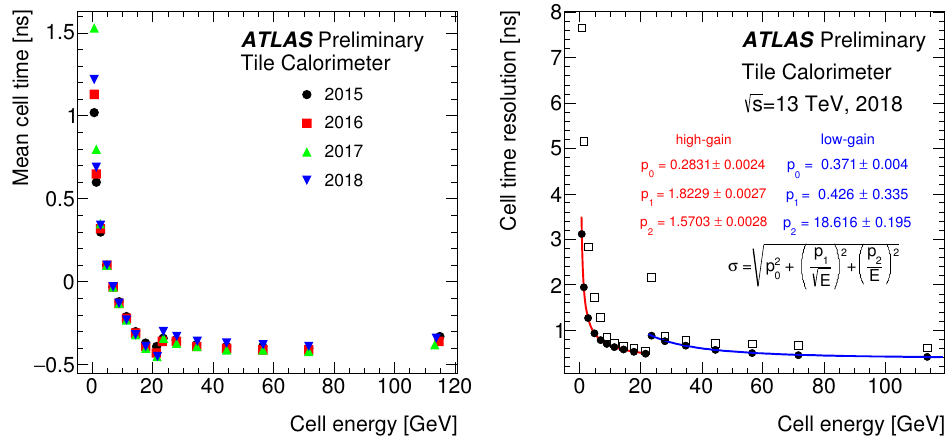
Figure 8. The mean cell time ( left ) and cell time resolution ( right ) as a function of the cell energy, as measured in cells associated to reconstructed jets. The statistical uncertainties are not visible since they are smaller than the symbols. The small discontinuity close to 20 GeV corresponds to the high/low-gain transition